Question: Express in one sentence what the figure is showing.
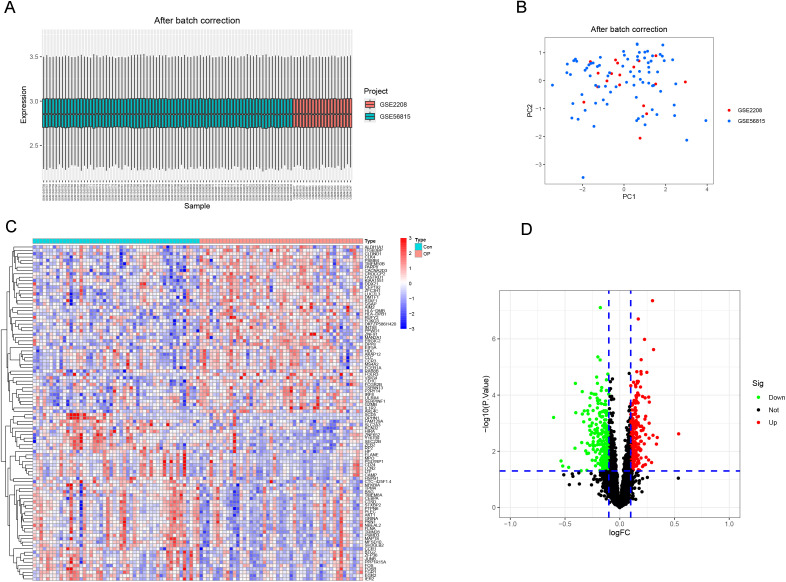
Answer: Batch effect correction and differential expression analysis of OP-related genes. (A) Box plot showing the expression distribution of the merged dataset after batch effect correction. (B) PCA plot of the corrected dataset, colored by sample group. (C) Heatmap of DEGs between OP samples and healthy controls. (D) Volcano plot visualizing the DEGs between OP and control groups, highlighting significantly up- and downregulated genes.